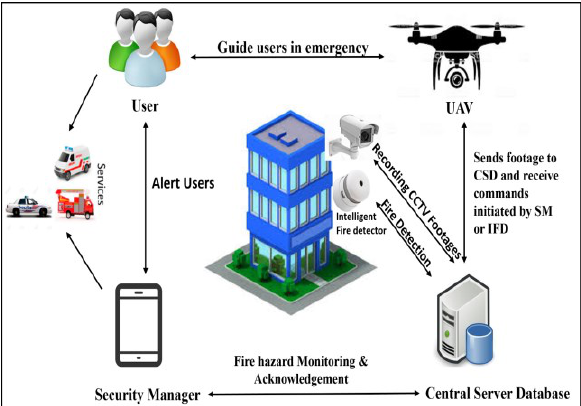
Figure 1. UAV based fire alarm